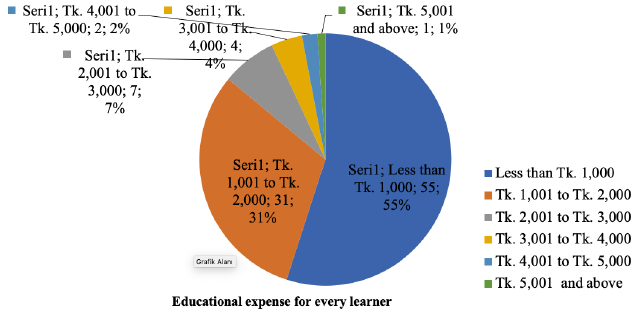
Figure 6: Educational expense for every learner